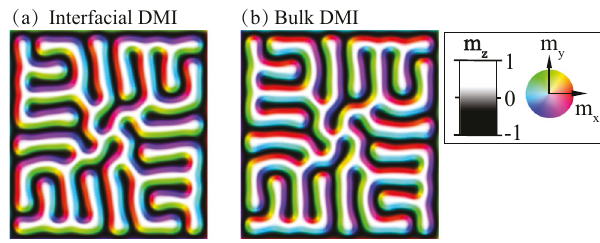
Fig. 4 Similarity of rami fi ed stripe skyrmions in bulk and interfacial Dzyaloshinskii – Moriya interaction (DMI). Structures of one stripe skyrmion for interfacial ( a ) and bulk ( b ) DMIs starting from the same initial con fi gurations. The sample size is 300 nm × 300 nm × 0.4 nm with the same model parameters as those for Fig. 1 except DMI coef fi cient D = 4 mJ m − 2 . The periodical boundary conditions are used in the simulations. The z-component of magnetization m z is encoded in grayscale shown in the left color bar. The in-plane spin component is encoded by the colors denoted by the right color distance between two nearby skyrmions is order of the stripe width, the skyrmion – skyrmion repulsion compress skyrmions into circular